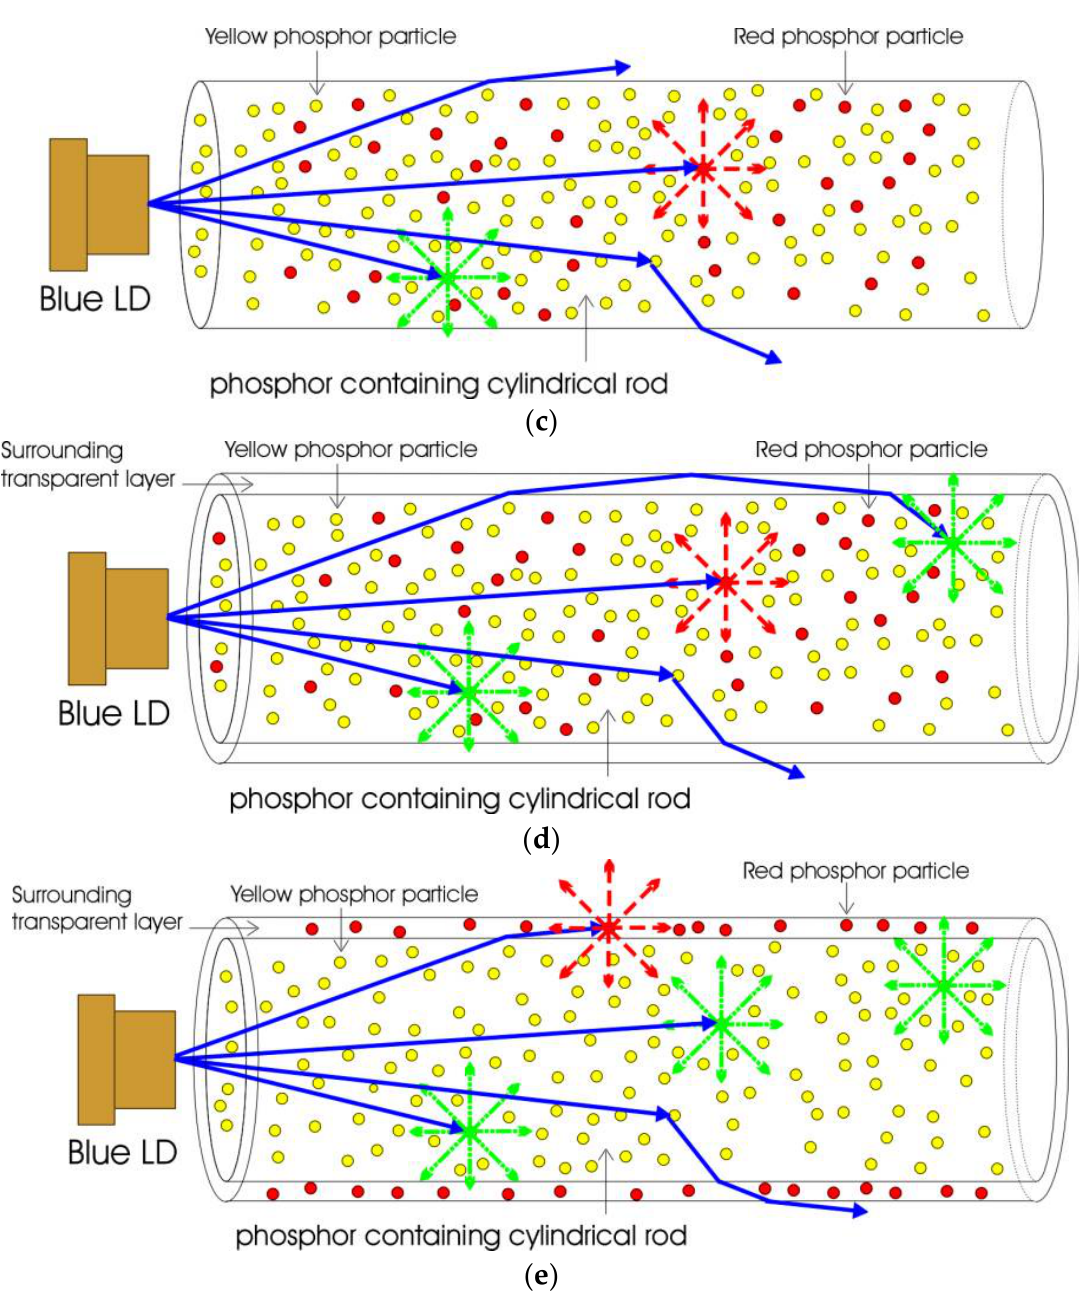
Figure 1. Schematic diagrams of ( a ) yellow phosphor cylindrical rod, ( b ) yellow phosphor cylindrical rod with surrounding transparent layer, ( c ) yellow and red phosphors cylindrical rod, ( d ) yellow and red phosphors cylindrical rod with surrounding transparent layer and ( e ) yellow cylindrical rod and surrounding red phosphor layer used in this study.